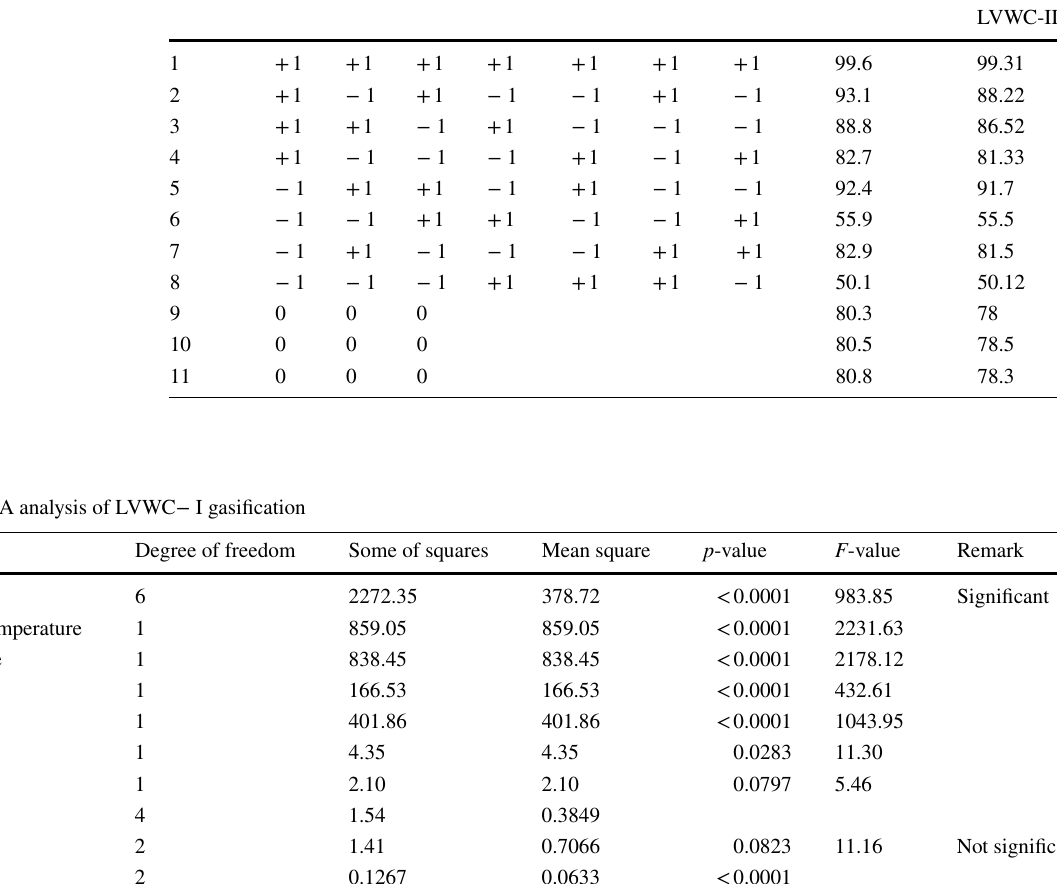
Table 7 2 3 full factorial design matrix and gasification results of LVWC